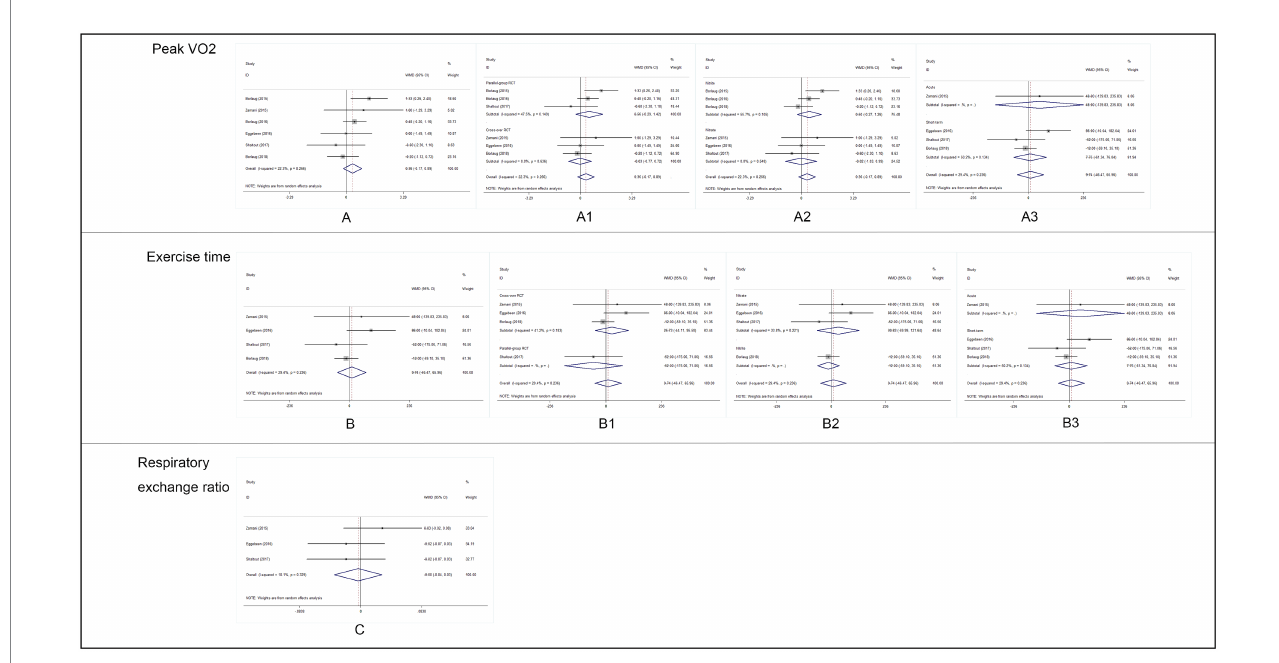
FIGURE 2 Analysis results of primary outcomes. (A) Forest plot of peak VO 2 , (A 1 ) : subgroup analysis by RCT design, (A 2 ) : subgroup analysis by intervention drug, and (A 3 ) : subgroup analysis by intervention duration. (B) Forest plot of exercise time, (B 1 ) : subgroup analysis by RCT design, (B 2 ) : subgroup analysis by intervention drug, (B 3 ) : subgroup analysis by intervention duration. (C) : Forest plot of respiratory exchange ratio (RER) during